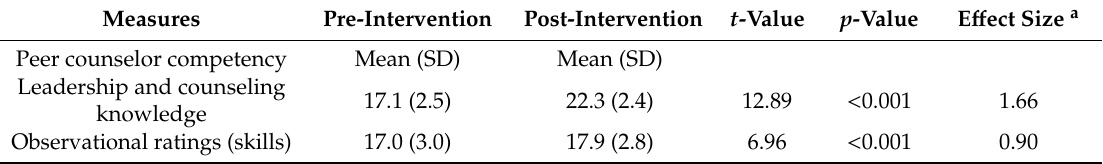
Observational ratings